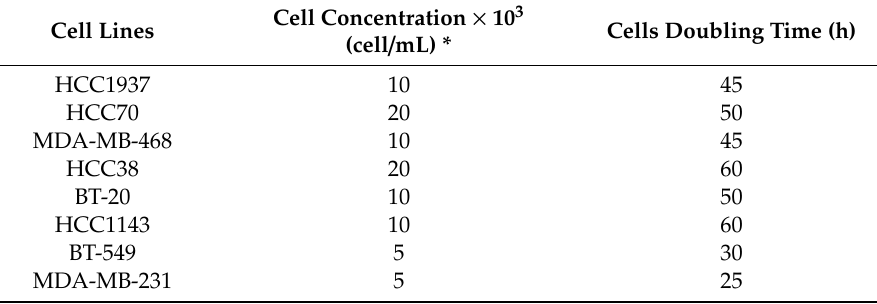
Table 2. Seeded cell concentrations per well used in cell viability